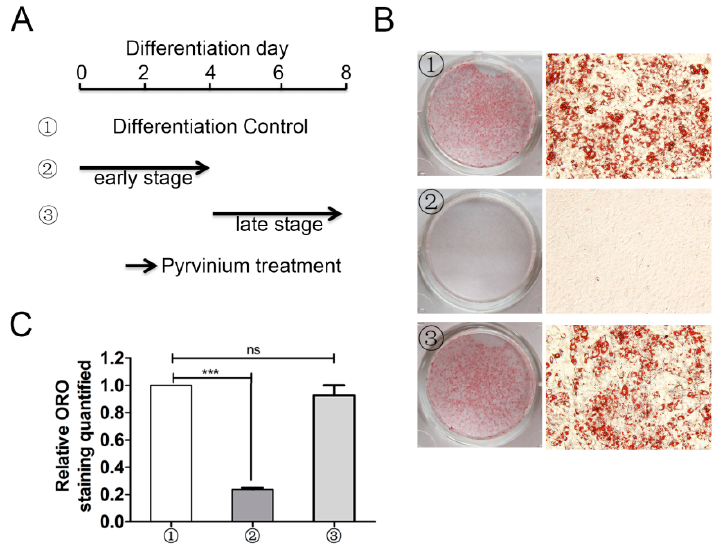
Figure 3. Anti-adipogenic e ff ects of pyrvinium during the early stages of adipogenic di ff erentiation. ( A ) A schematic model depicting pyrvinium treatment during C3H10T1 / 2 adipogenic di ff erentiation. ( B ) Representative photographs of each treatment group after Oil Red O staining. C3H10T1 / 2 cells were treated with 18 nM pyrvinium for the indicated duration and cell monolayers were stained with Oil Red O after 8 days of adipogenic di ff erentiation. ( C ) Spectrometric quantitative analysis of Oil Red O (ORO) staining. The stained adipocytes were extracted with isopropyl alcohol and the absorbance at 520 nm was measured. The data are presented as mean ± SEM from three independent experiments. (*** p < 0.001 compared with control).